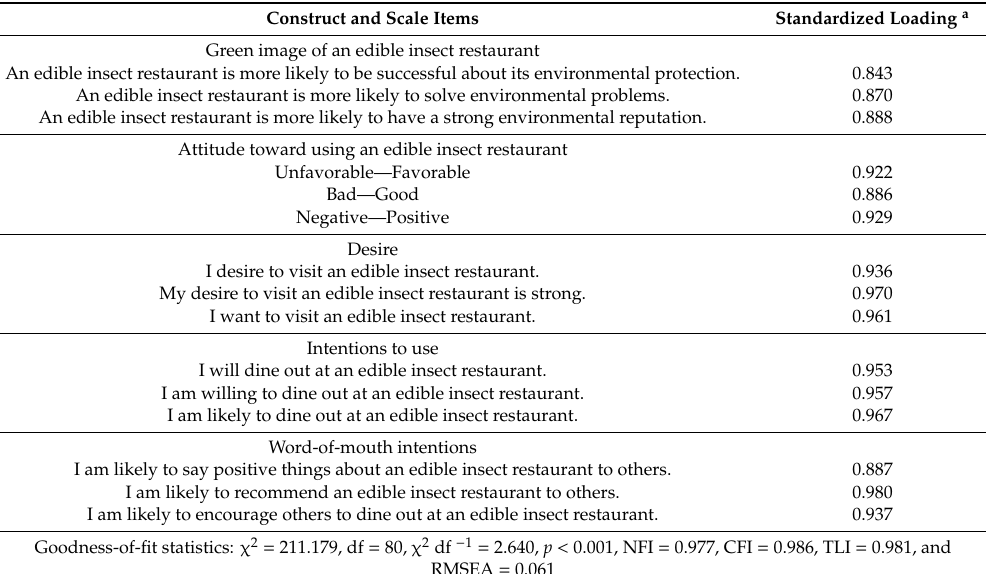
Table 1. Confirmatory factor analysis: items and